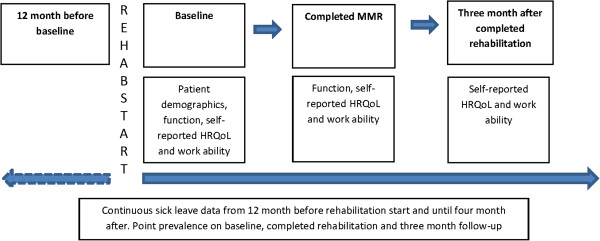
Flowchart of outcomes.